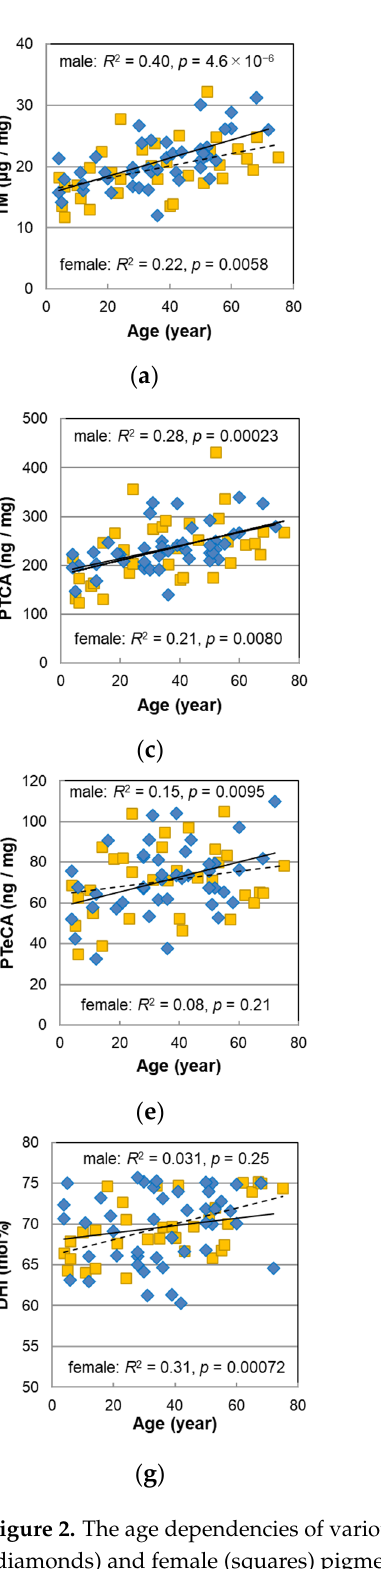
( g ) 5,6-dihydroxyindole (DHI) mol% in eumelanin of hair. ( h ) Pheomelanin mol% in hair. Lines represent the fitted curves. Solid line denotes male sex and dashed line denotes female sex. The